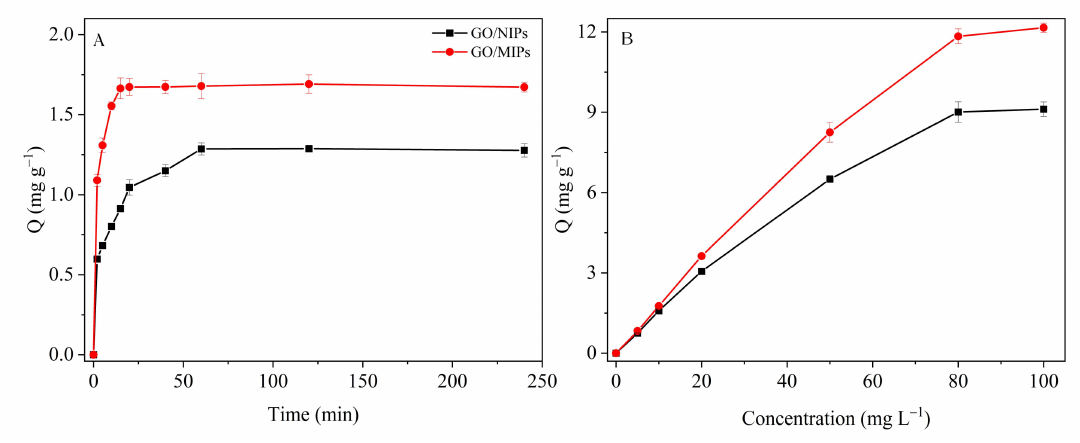
Figure 2. Dynamic ( A ) and static ( B ) adsorption of NOR by GO/MIPs and